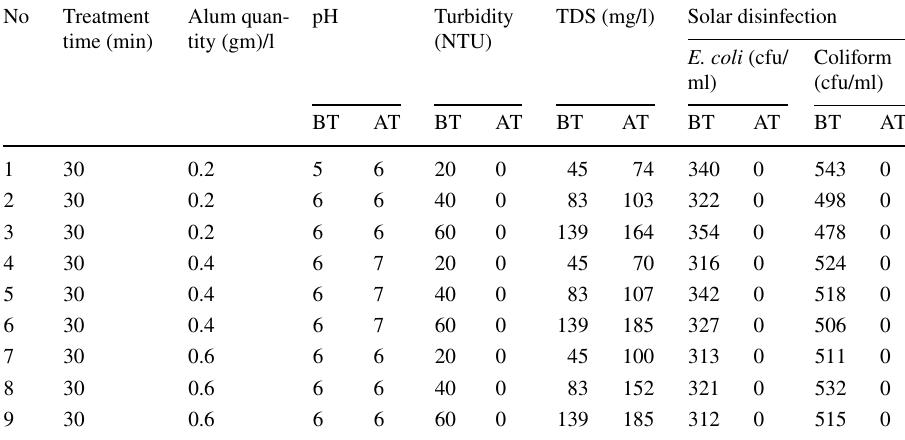
Table 1 Effect of alum and solar disinfection on various turbid